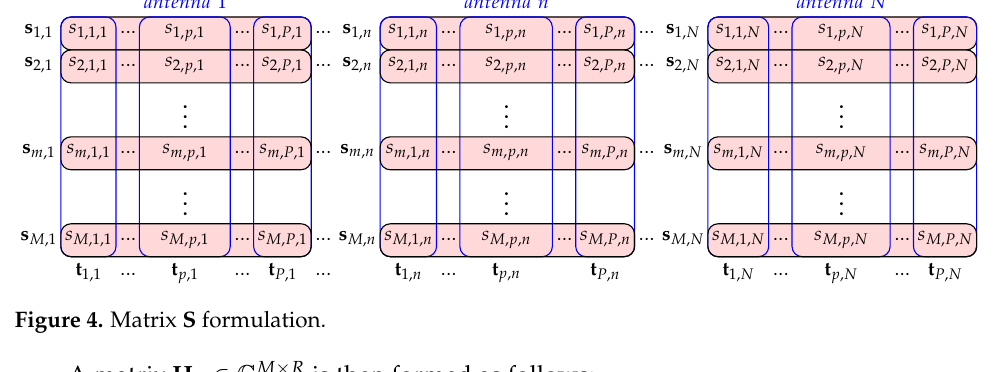
Figure 4. Matrix S formulation